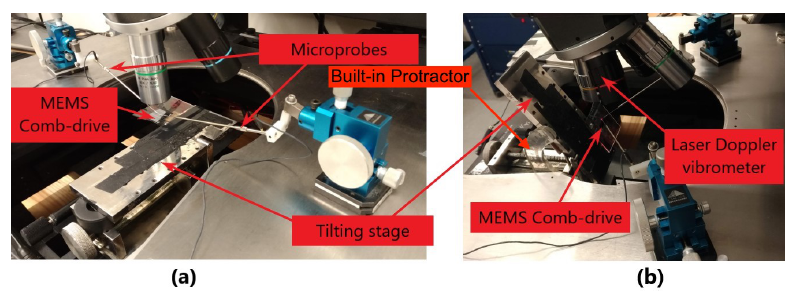
Figure 4. Experimental setup for ( a ) out-of-plane and ( b ) in-plane